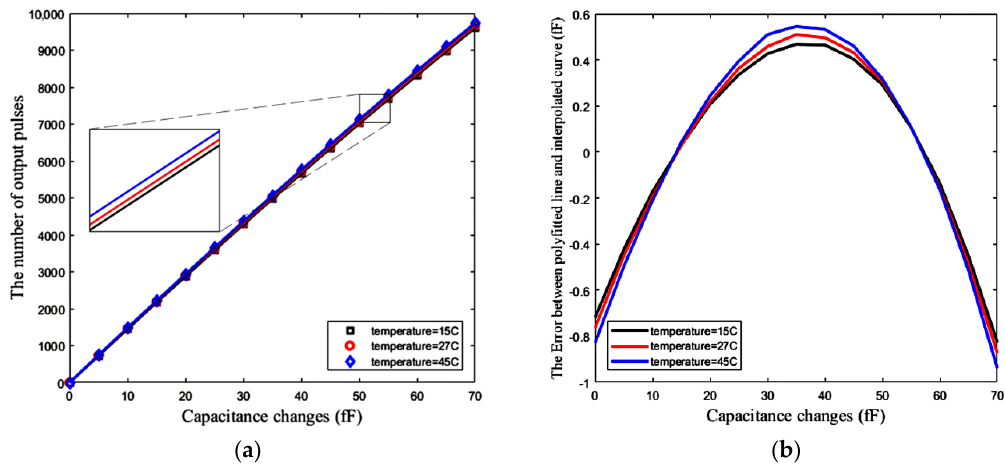
Figure 19. ( a ) Number of pulses versus capacitance changes Δ C (fF), ( b ) Error between the simulation results for 15 different values of Δ C and the polynomial fitted line (at three different temperatures of 15 °C, 27 °C and 45 °C).